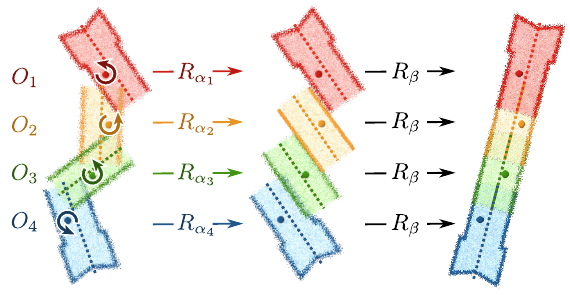
Figure 5. Horizontal rotations of the point clouds for horizontal alignment. (Left) the longitudinal axis of each scan is defined us- ing PCA. (Middle) each scan is given the same orientation. Note that the rotation angles α i are different. (Right) the point clouds are aligned by applying a rotation with a common angle β . Scan centers O i remain fixed during the whole